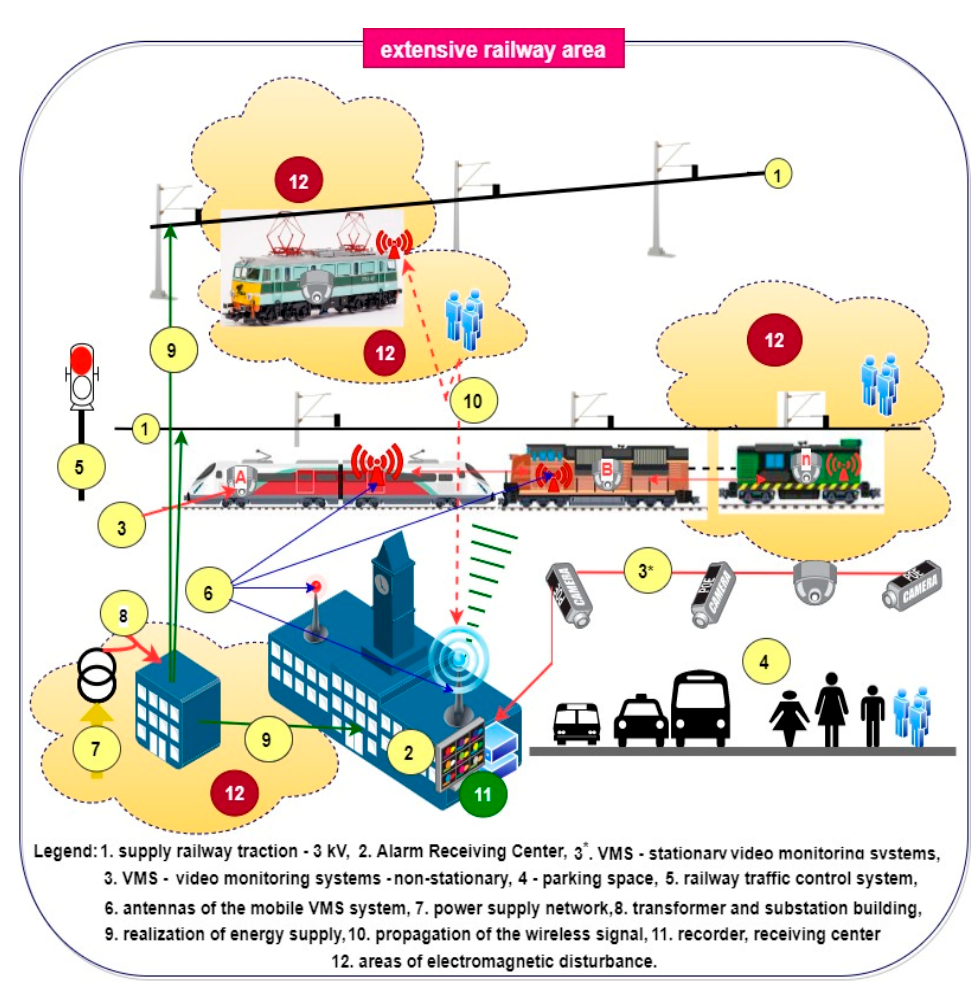
Figure 1. Operational issues, i.e., environment, electromagnetic interference, legal restrictions, telecommunications, etc., resulting from VMS within a railway area.